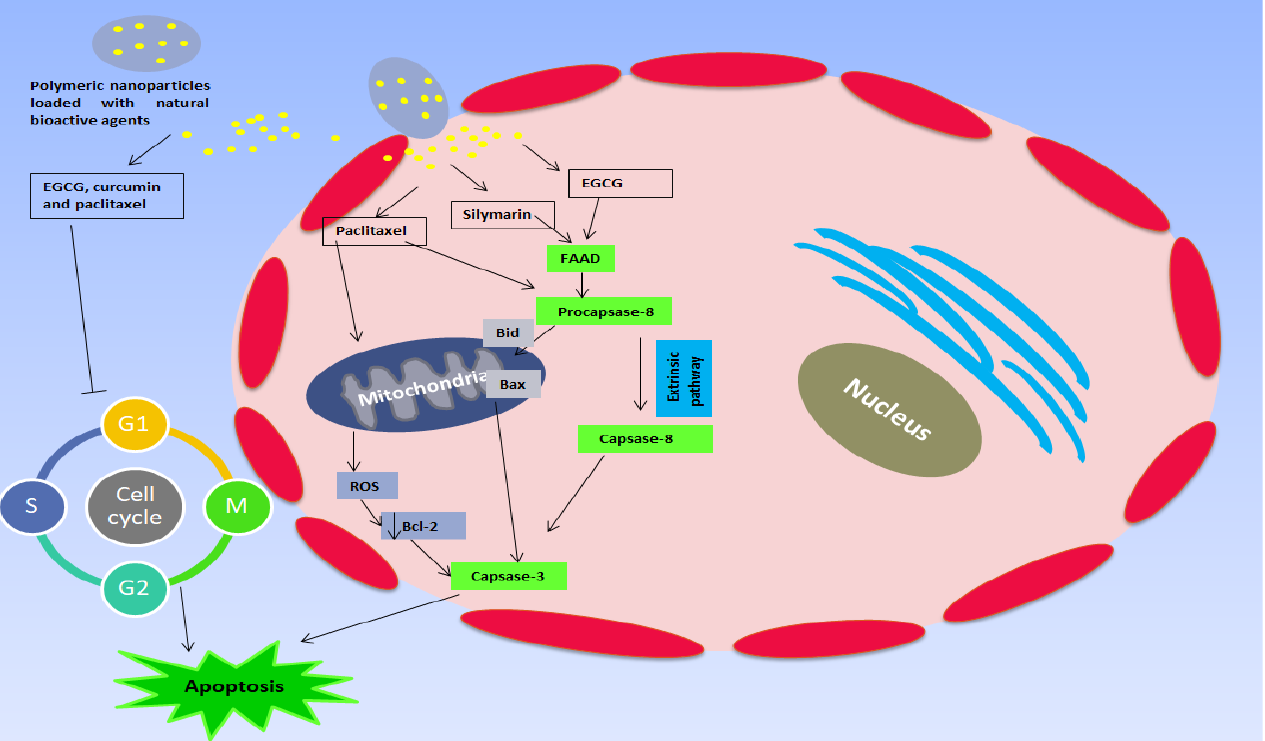
Figure 6. Schematic representation showing the mechanisms by which natural bioactive agents can act as anticancer agents after release from polymeric nanoparticles. act as anticancer agents after release from polymeric